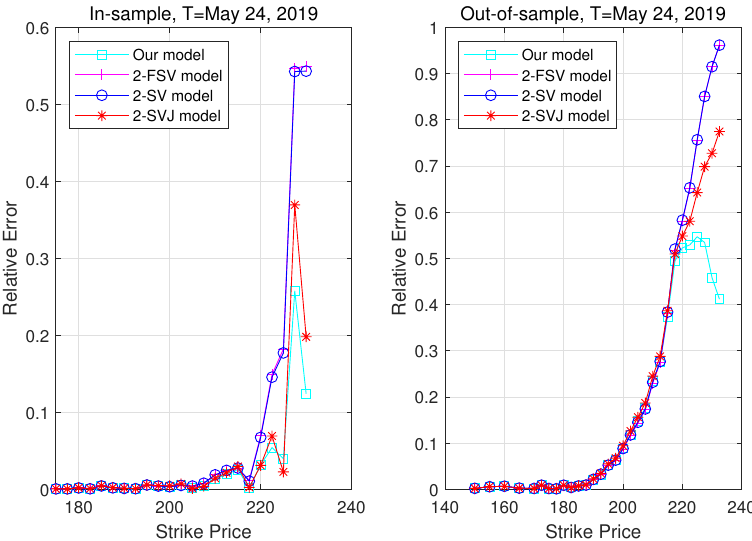
Figure 1. The comparison of predicted prices of four model specifications and market prices